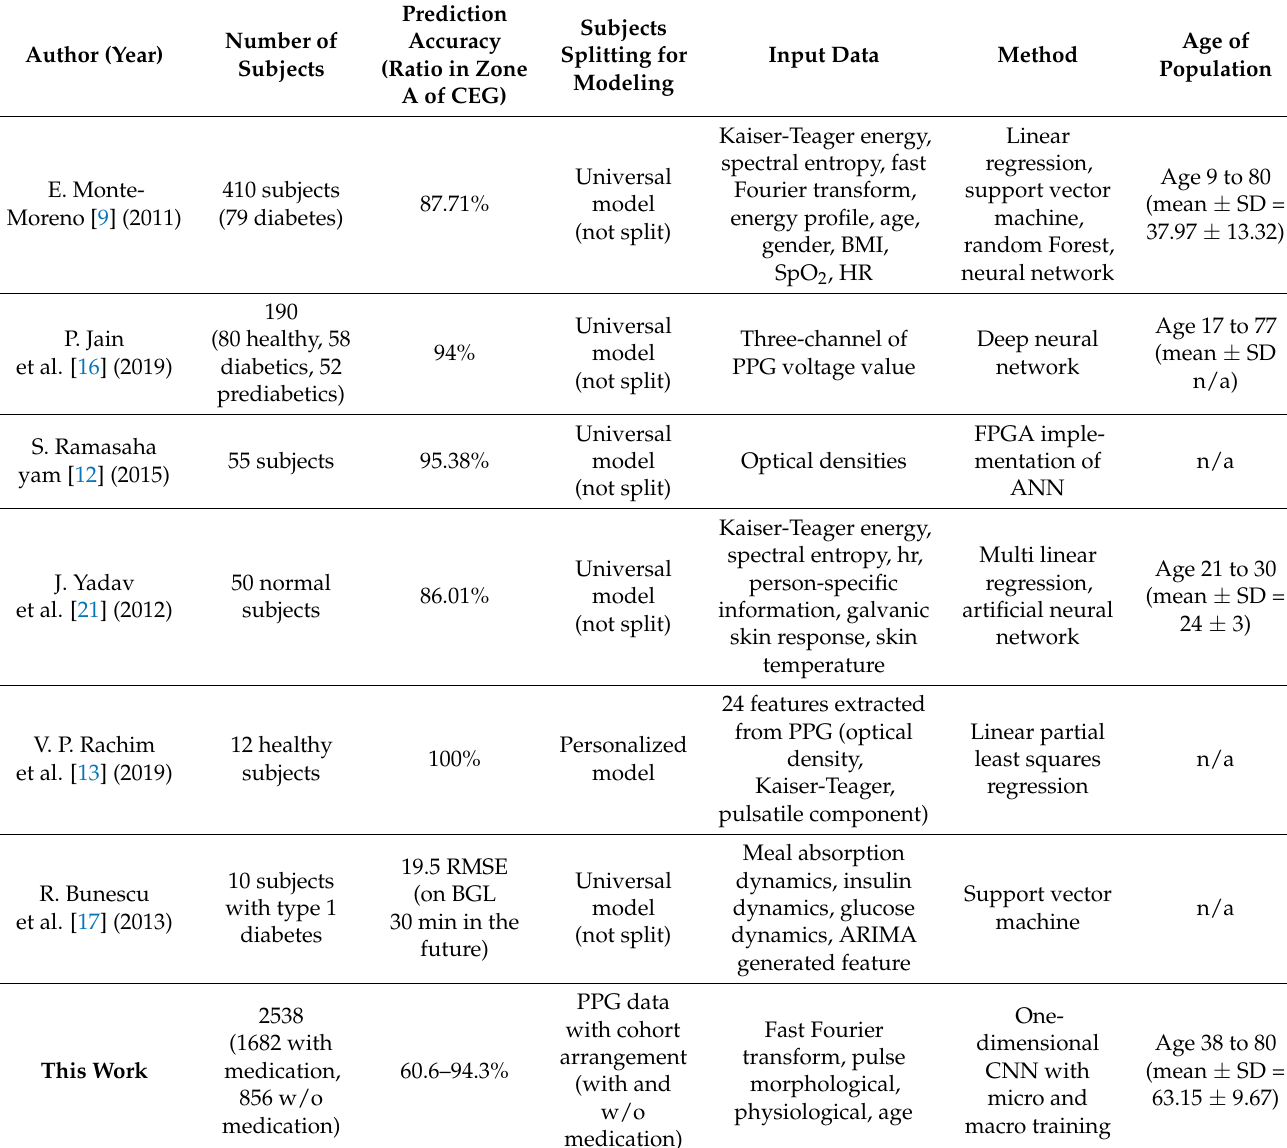
Table 1. Comparison of PPG-based NIBG predictions in the past decade with the present